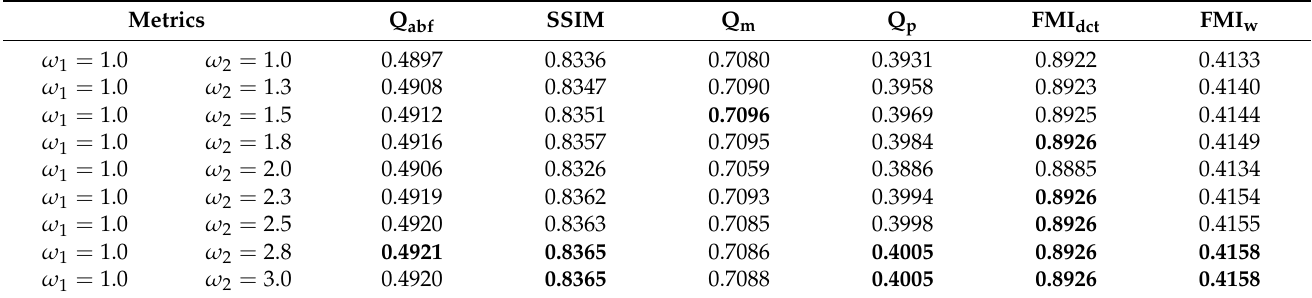
Table 4. Averages of the six metrics for different ω 2 on ten pairs of source images from two public datasets. Numbers in bold font represent the best value.